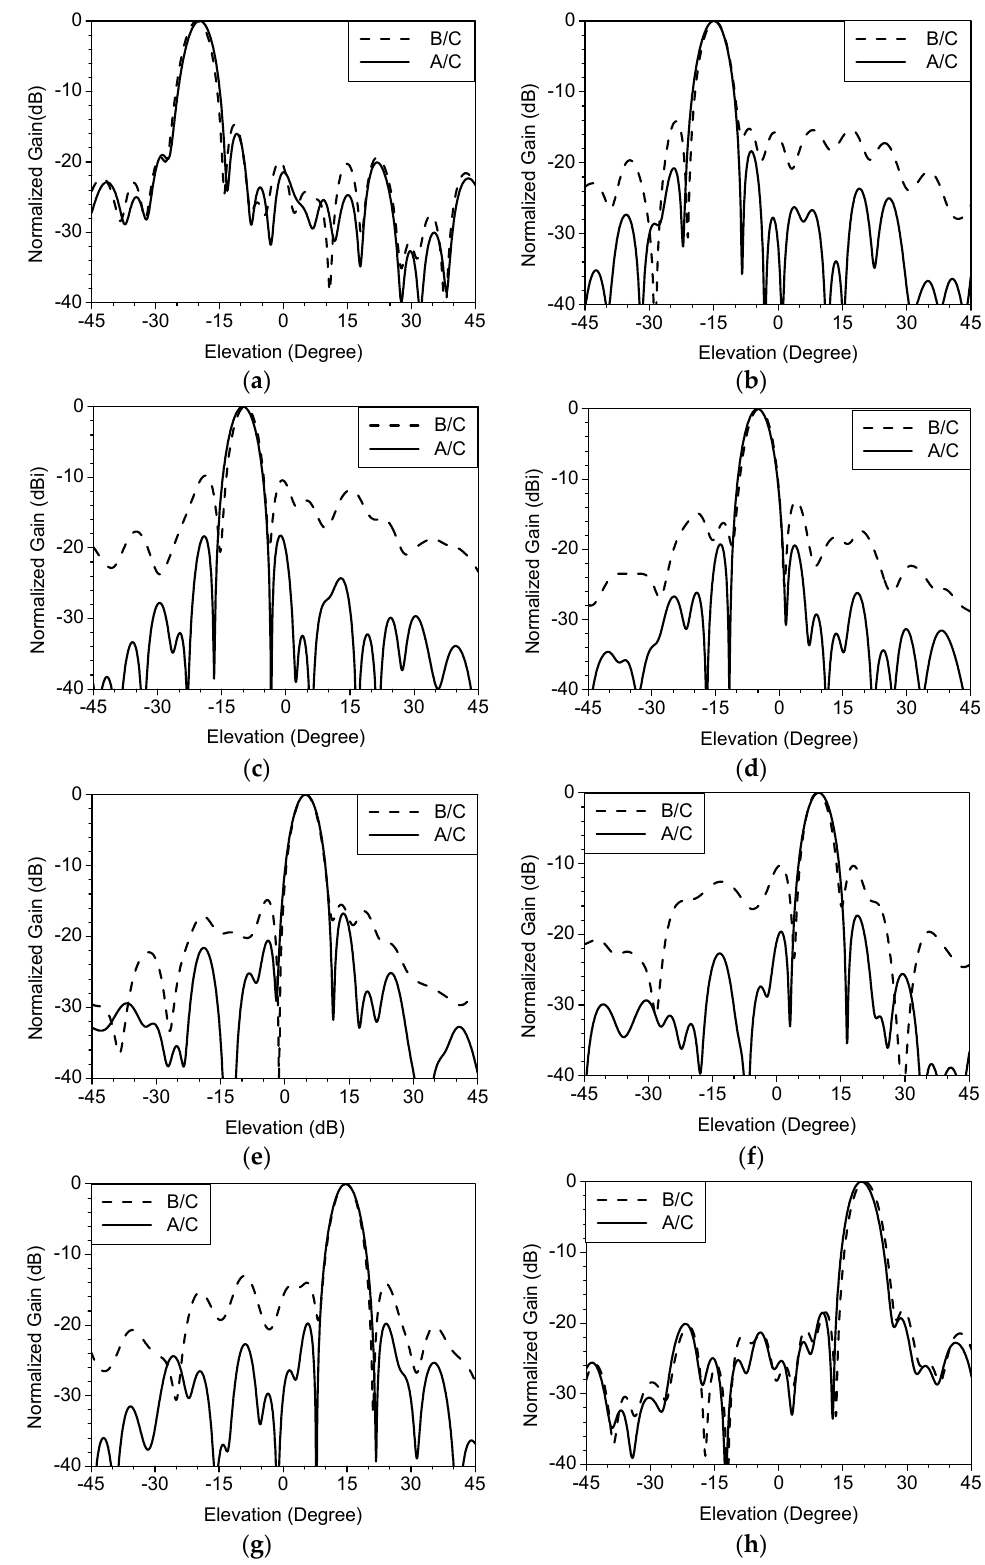
Figure 15. Radiation patterns of the implemented phased-array antenna with/without calibration (B/C: before calibration, A/C: after calibration) at ( a ) θ 0 = − 20°, ( b ) θ 0 = − 15°, ( c ) θ 0 = − 10°, ( d ) θ 0 = − 5°,